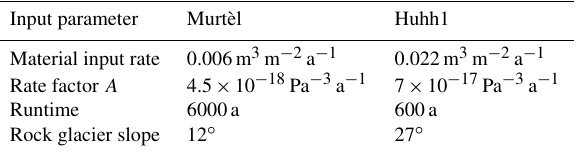
Table 3. Specific model input parameters for the rock glaciers. The sediment–ice input describes the volume of debris deposited on the accumulation area per year. The rate factor A is derived from Eq. (11) and the runtime of each rock glacier model is selected due to its approximated age (see Sect.